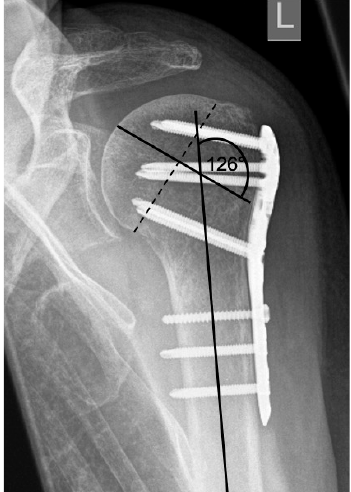
Figure 2. Calculation of the humeral head–shaft angle in the a.p. radiographic path by drawing three lines and the intersection of the line along the long axis of the humeral shaft with the perpendicular to the line of inferior + superior articular surface [22,23].